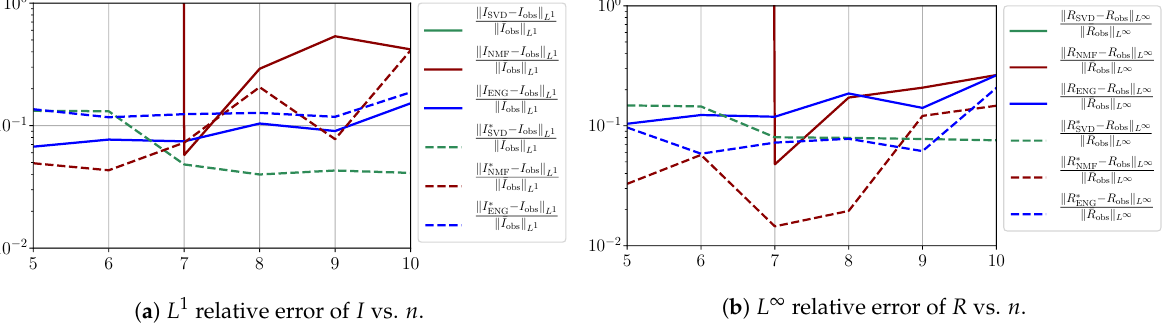
Figure A12. Forecasting errors of I and R (from T =